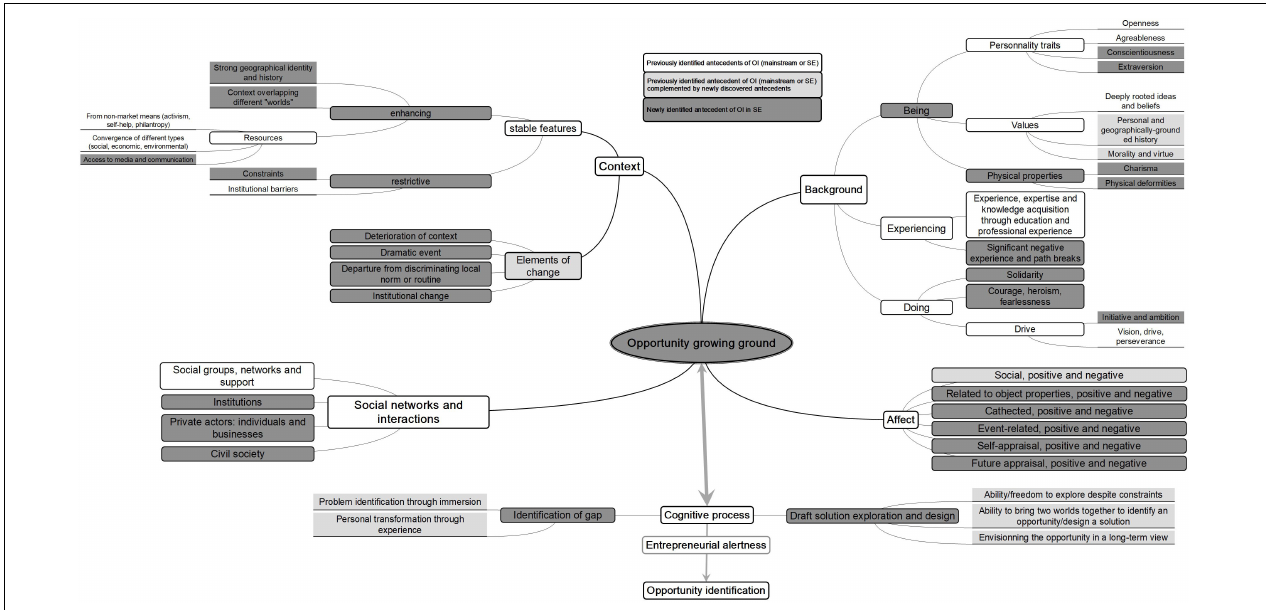
FIGURE 7 | Full model of social entrepreneurship opportunity